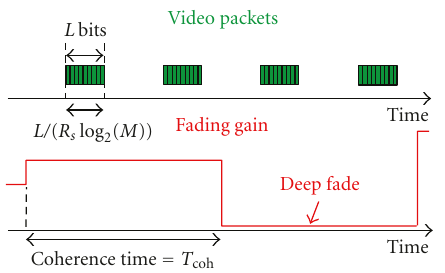
Figure 4: Video packet stream and fading gain versus time; in this example, 2 video packets are transmitted during the channel coherence time, in which case a packet group consists of 2